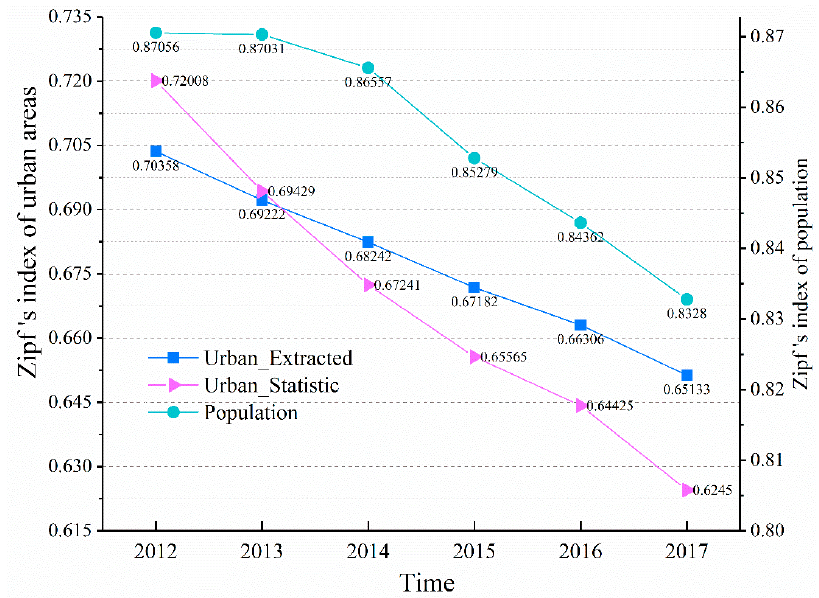
Figure 11. Variations in the Zipf’s index for extracted urban areas, statistic urban areas, and popu- lation data of the YRD from 2012 to 2017.